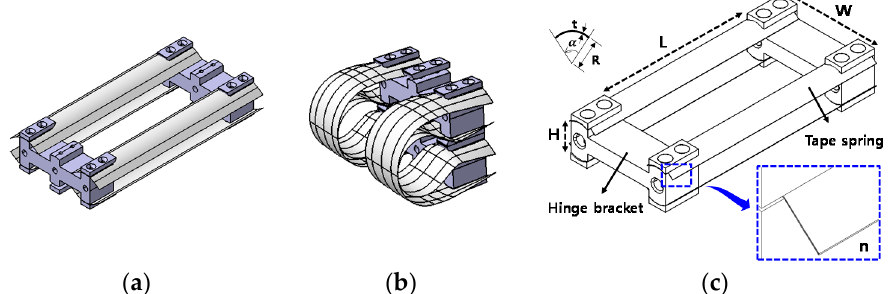
Figure 1. Configuration of multi-layer TS hinges: ( a ) unfolding configuration, ( b ) folding configuration, ( c ) design parameters of multi-layer TS hinges.